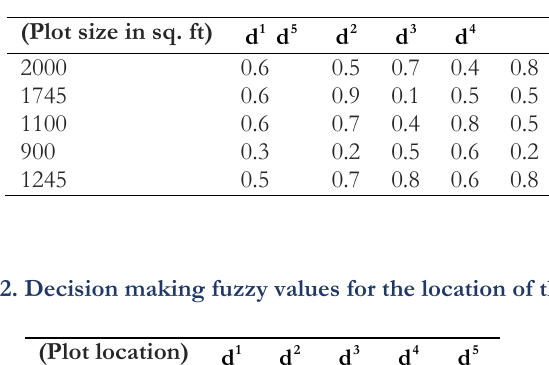
Table 1. Decision making fuzzy values for the size of the plot.